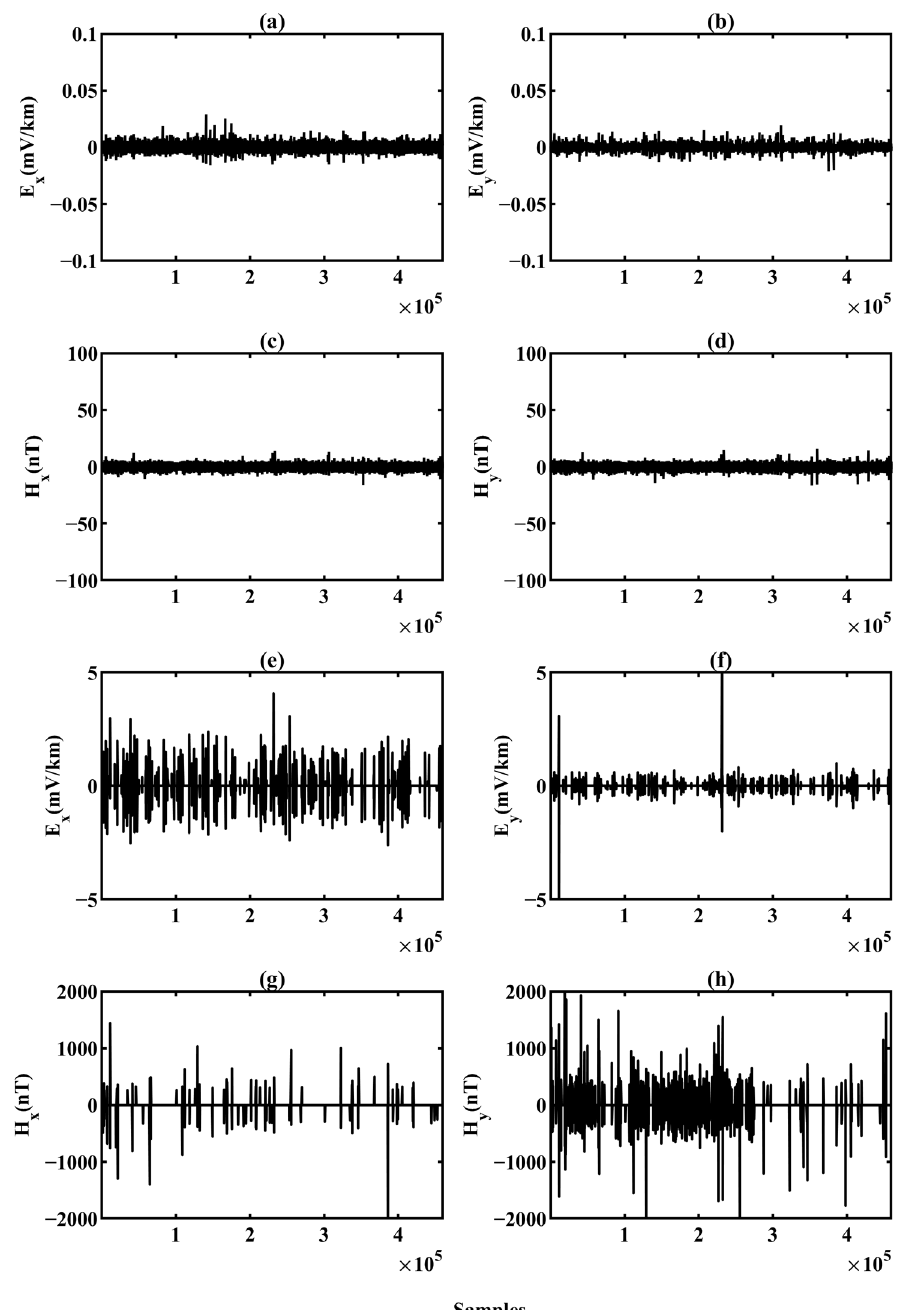
Figure 11. The denoising results of the 5th test dataset. ( a – d ) are the denoising results for e x , e y , h x , and h y , respectively. ( e – h ) are the extracted noise for e x , e y , h x , and h y , respectively.